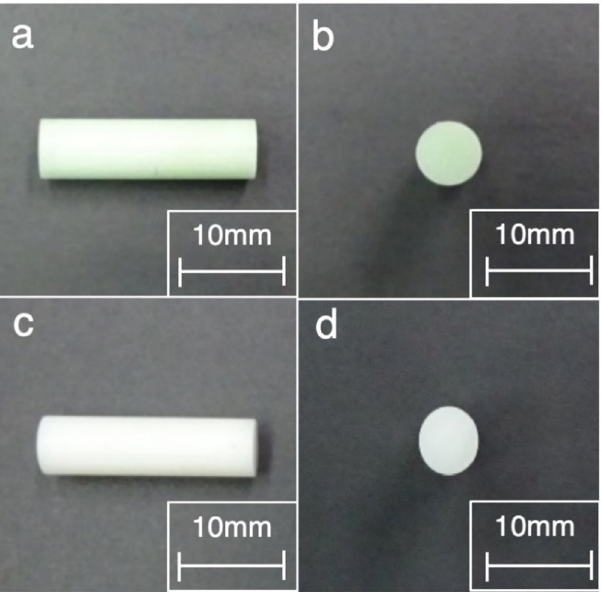
Figure 4. Photograph of the pin made by bone cement showing the following: ( a ) the side view of Endurance (DePuy CMW, Blackpool, UK), ( b ) the front view of Endurance, ( c ) the side view of Palacos R (Heraeus Kulzer, Wehrheim, Germany), and ( d ) The front view of Palacos R.